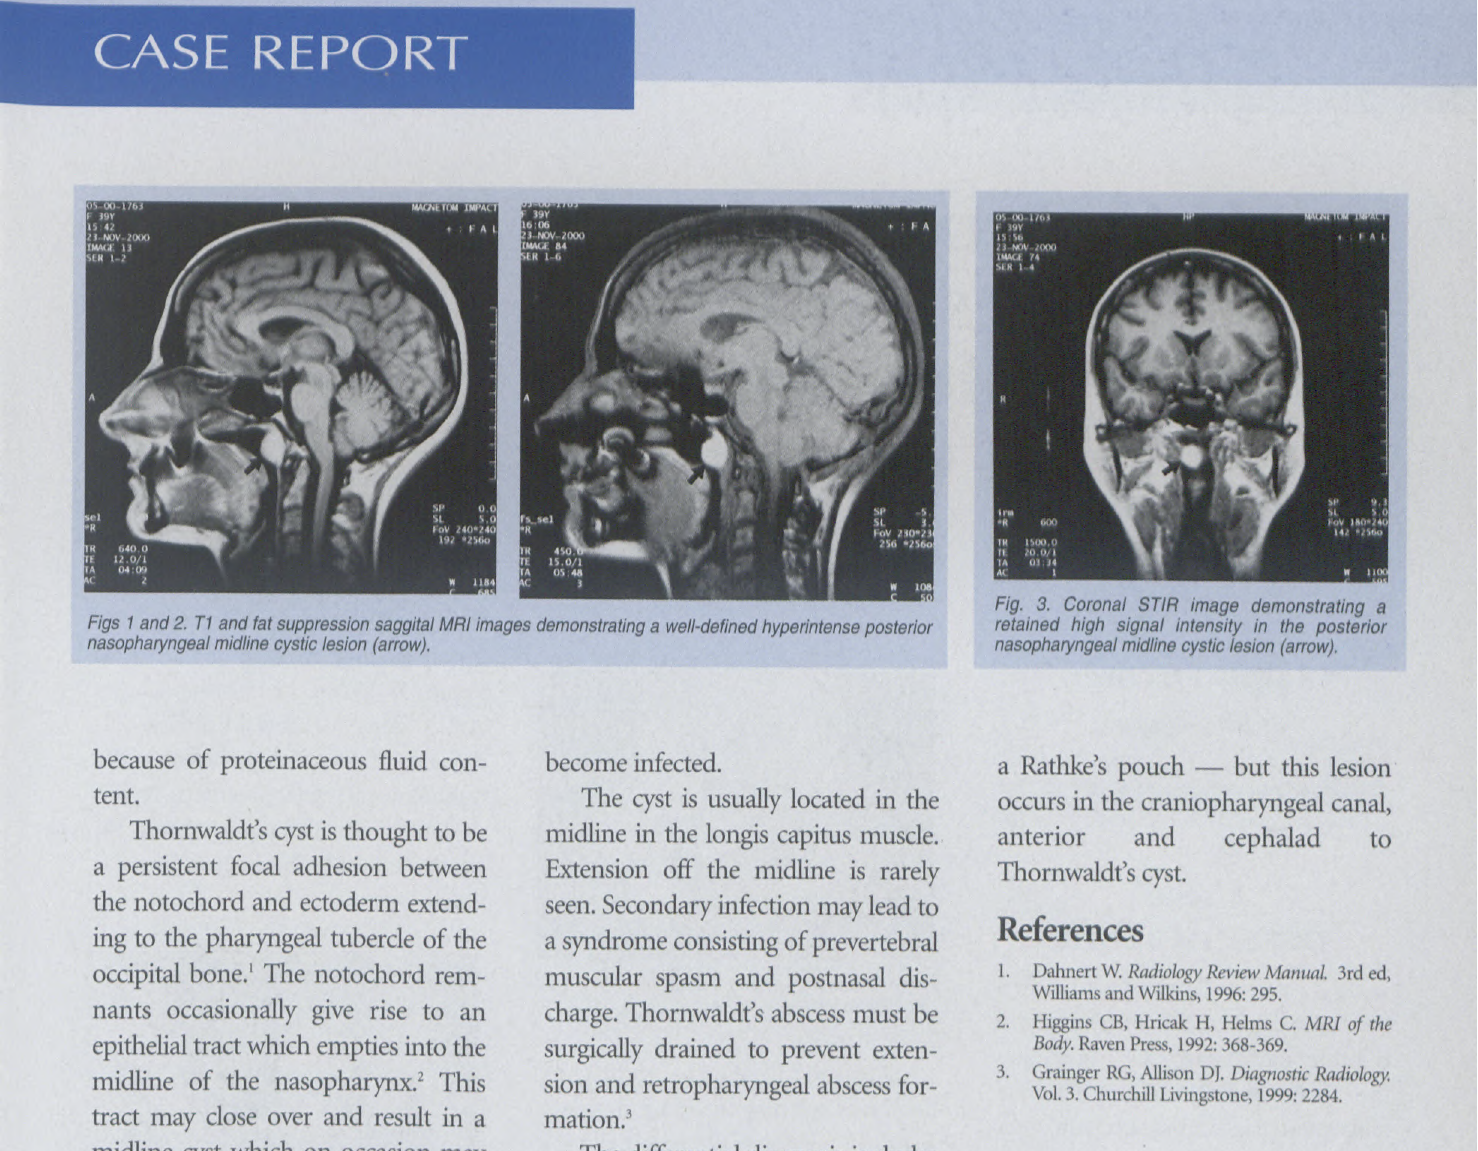
a Rathke's pouch - but this lesion occurs in the craniopharyngeal canal,